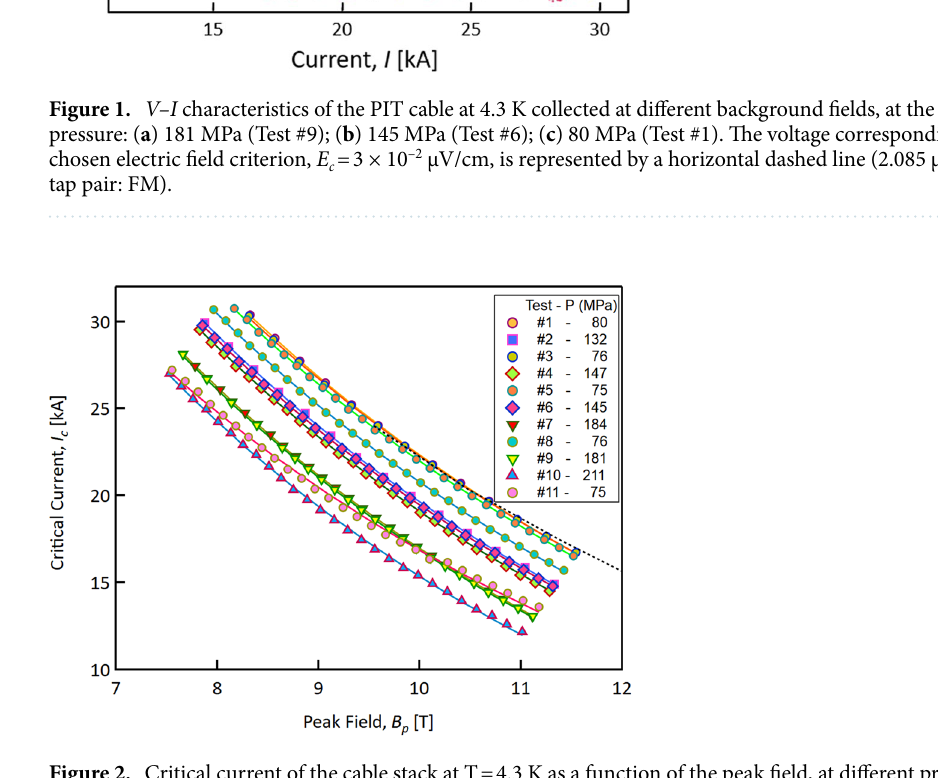
Figure 2. Critical current of the cable stack at T = 4.3 K as a function of the peak field, at different pressure levels ranging from 80 to 210 MPa. Markers represent the experimental data, whereas the lines are fits to Eq. (1). The black dotted line is the cable I c expected from transport measurements on witness